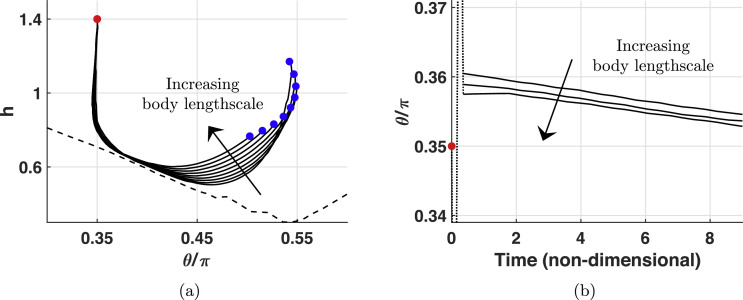
Simulated swimming of virtual promastigotes with differing body length scales. (a) Beginning from a sample initial condition of (θ,h)=(0.35π,1.4), with the initial location in phase space being shown in red and the simulation endpoints in blue, the smoothed paths of virtual swimmers are depicted as black curves. We simulate virtual promastigotes with a modified body length scale, where the aspect ratio of the body is kept fixed and the length of the body is sampled from a range of 7–17µm, representing typical variation in Leishmania. The black dashed line approximately separates off configurations that represent intersection with the boundary. We observe qualitatively-unchanged swimming behaviour in the presence of a repulsive surface potential, with reduced deflection being seen for larger-bodied swimmers. (b) Simulating the swimmers in the absence of short range boundary forces, halting prior to boundary contact, shown is a time series plot of the evolution of θ/π, with the initial configuration of all cells being (θ,h)=(0.35π,1.4) and length scales sampled from the same range as in (a). Greater alignment towards the boundary is observed for swimmers with increased body length scales. The dotted section of the curve shows an initial unsmoothed transient, with the common initial value highlighted in red. (For interpretation of the references to colour in this figure legend, the reader is referred to the web version of this article.)